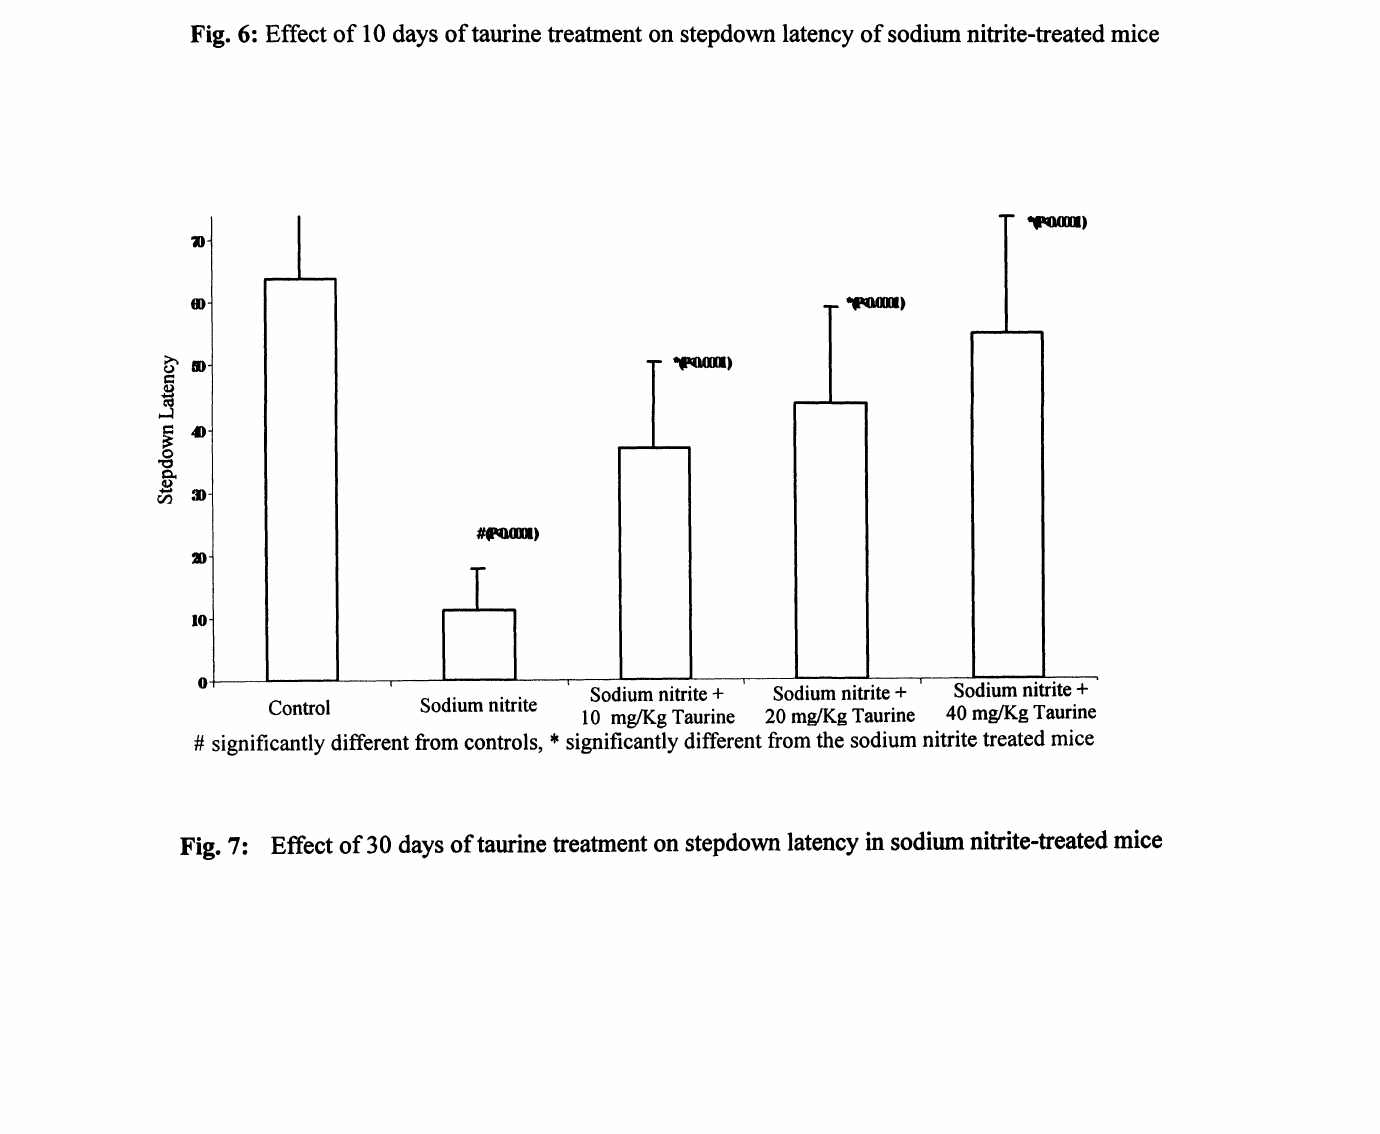
Fig. 6: Effect of 10 days of taurine treatment on stepdown latency of sodium nitrite-treated mice